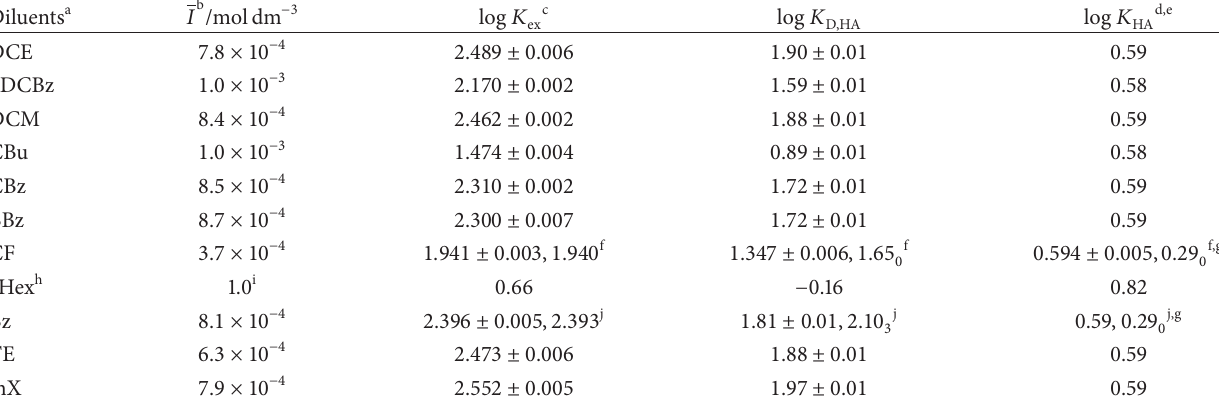
, 𝐾 ) at 298 K. HA D , HA